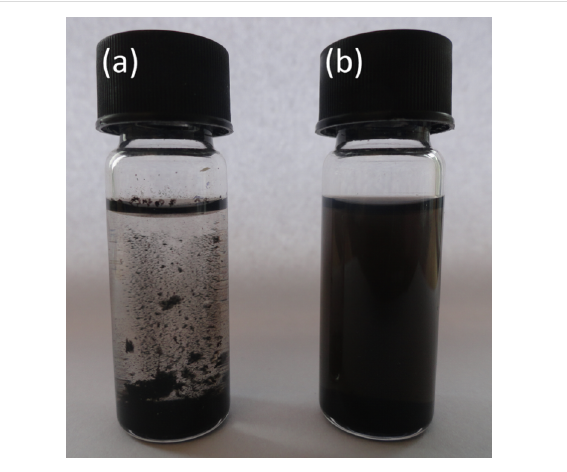
Figure 5: (a) Dispersion of MWCNTs starting material; (b) dispersion of b-MWCNTs.